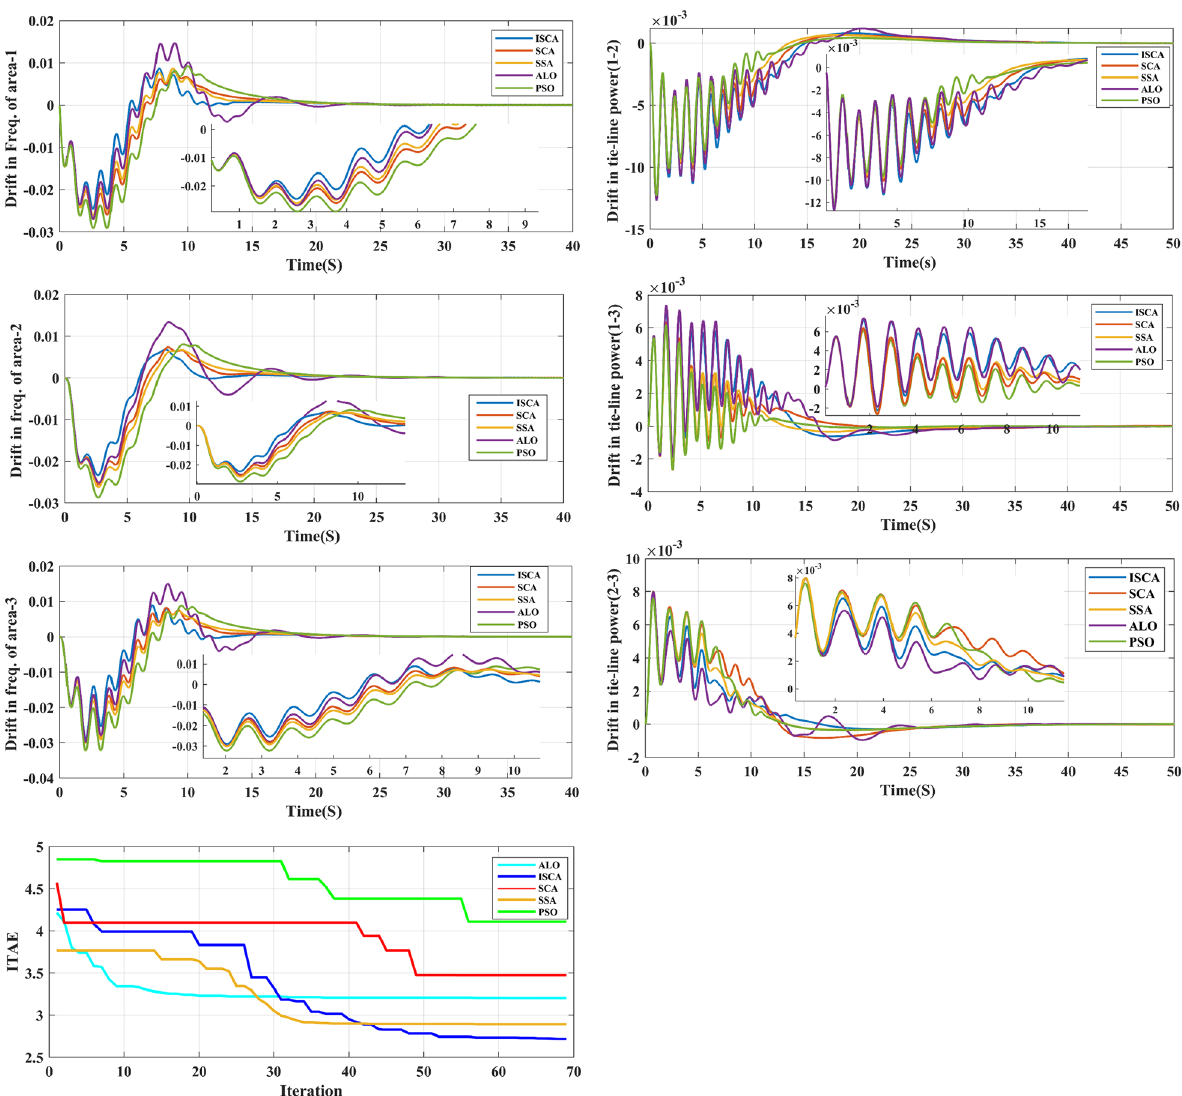
Fig. 7 Transient responses of frequency and tie-line power of all areas and convergence curves of the various algorithms for the three-area system with physical constraint and SLD of 1% in area-1 with the proposed and other algorithms